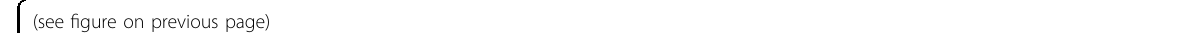
Fig. 1 Cryo-EM structures of the human dimeric TOM core complex and trimeric TOM. a Representative gel fi ltration chromatography pro fi le of the puri fi ed TOM core complex. b Schematic diagram of each subunit of the TOM core complex. c Top view of the overall structure of the TOM core complex (top panel) and side view (bottom panel) with each subunit individually colored. Lipids are indicated with spheres. OM indicates the outer membrane. IMS represents intermembrane space. d Interactions between Tom40 and Tom22 with lipid molecules as bridges. Tom40 and Tom22 are colored in chartreuse and blue, respectively. The phosphate group of PL0 forms a hydrogen bond with K105 of Tom22, and the acyl chains of PL0 hydrophobically interact with Tom40 and Tom22. PL6 interacts with N156 of Tom40 and R82 of Tom22, and PL7 interacts with Y78 and R82 of Tom22. e Interactions between Tom7 and the PL5 molecule. The connecting loop in Tom7 is labeled. f PL3 is involved in the interaction between Tom40 and Tom6. PL3 interacts with R38 and R43 of Tom6 and three residues (S320, W322, and R348) of Tom40. g Overall structure of the trimeric TOM complex from the cytosol view. Three Tom40s were named Tom40a, Tom40b, and Tom40c. h Structural alignment between the Tom40 dimer (chartreuse) and Tom40 trimer (purple) showing the rotation of Tom40. i Schematic diagram of the dimer-trimer conversion